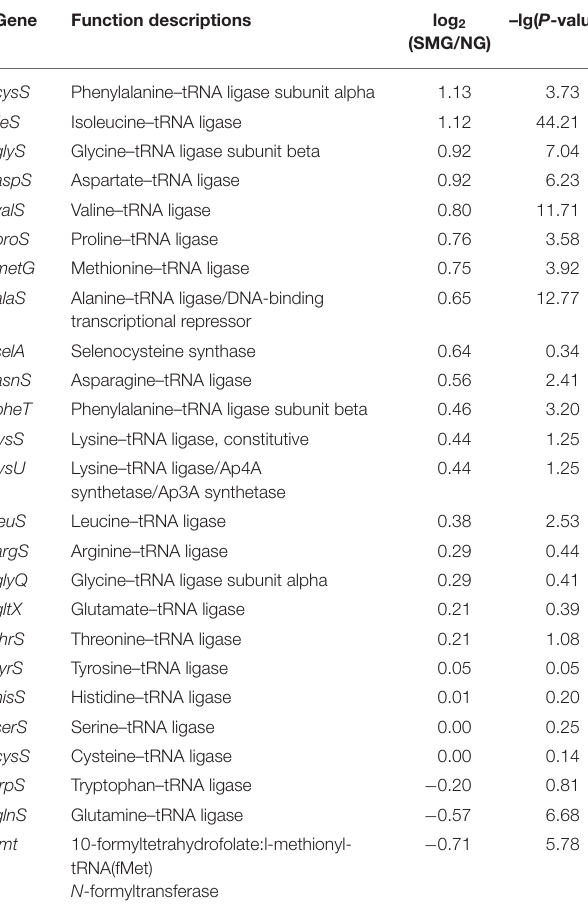
TABLE 1 | Transcription changes of ribosomal genes. TABLE 2 | Transcription changes of aminoacyl-tRNA biogenesis